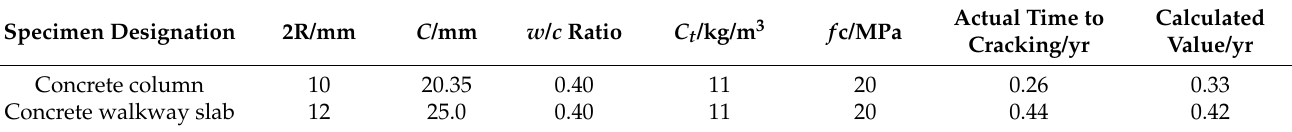
Table 5. Results comparison of the present model with measuring